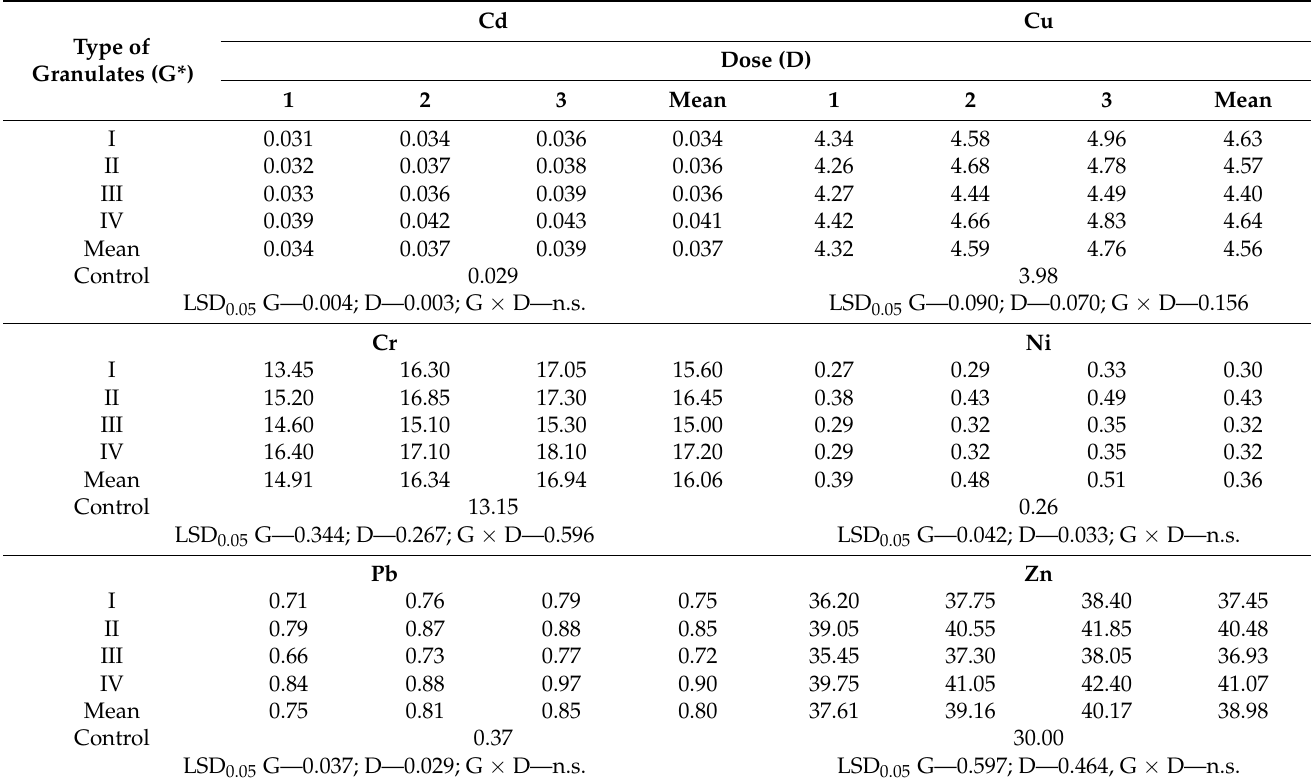
Table 6. Content of Cd, Cu, Cr, Ni, Pb and Zn in triticale (in mg · kg − 1 DM) to pot under effect of sludge-ash